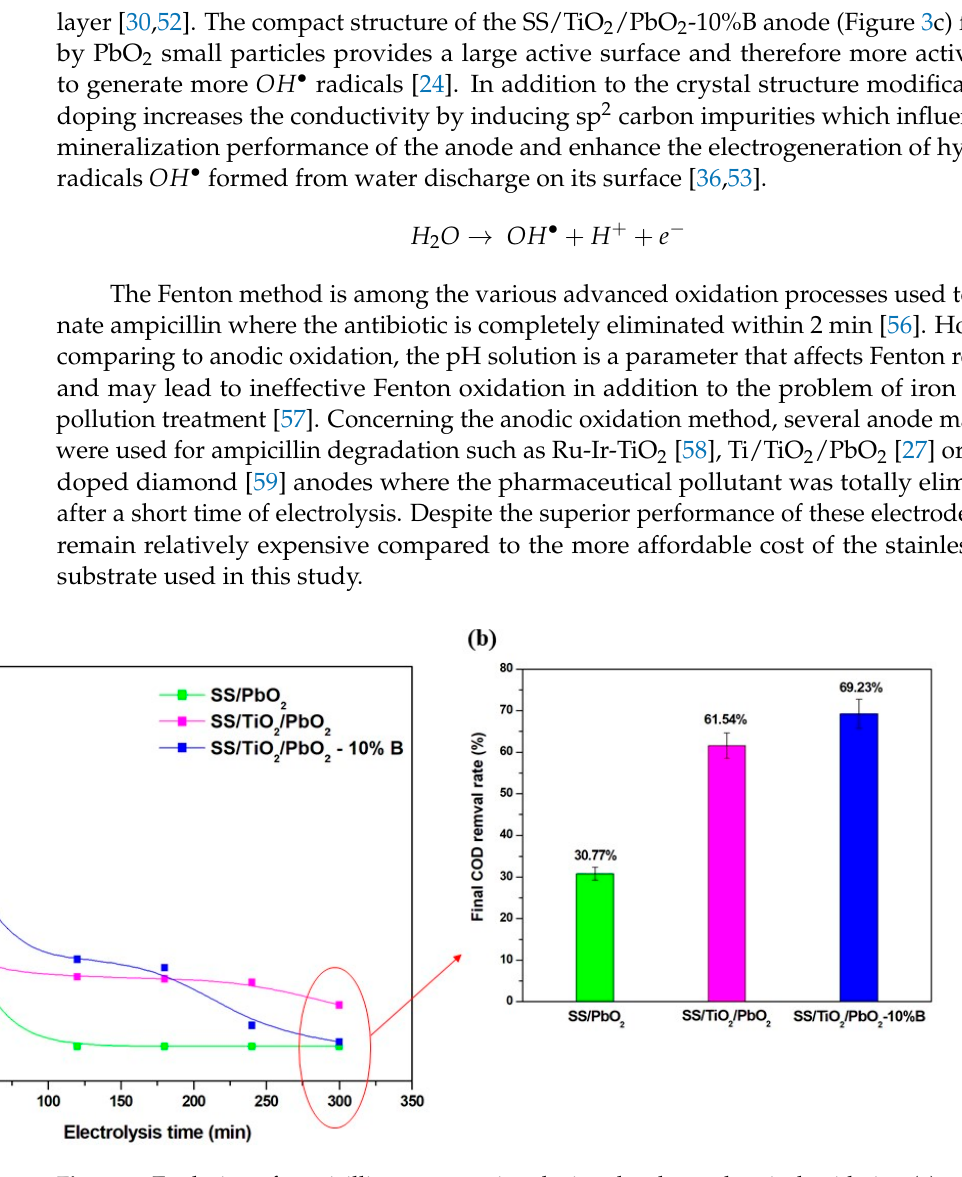
Figure 9. Evolution of ampicillin concentration during the electrochemical oxidation ( a ) and COD removal rate at the end of the treatment with the different PbO 2 anodes ( b ). Experimental conditions: C AMP = 105 mg L − 1 , j = 50 mA cm − 2 , [Na 2 SO 4 ] = 0.1 M.